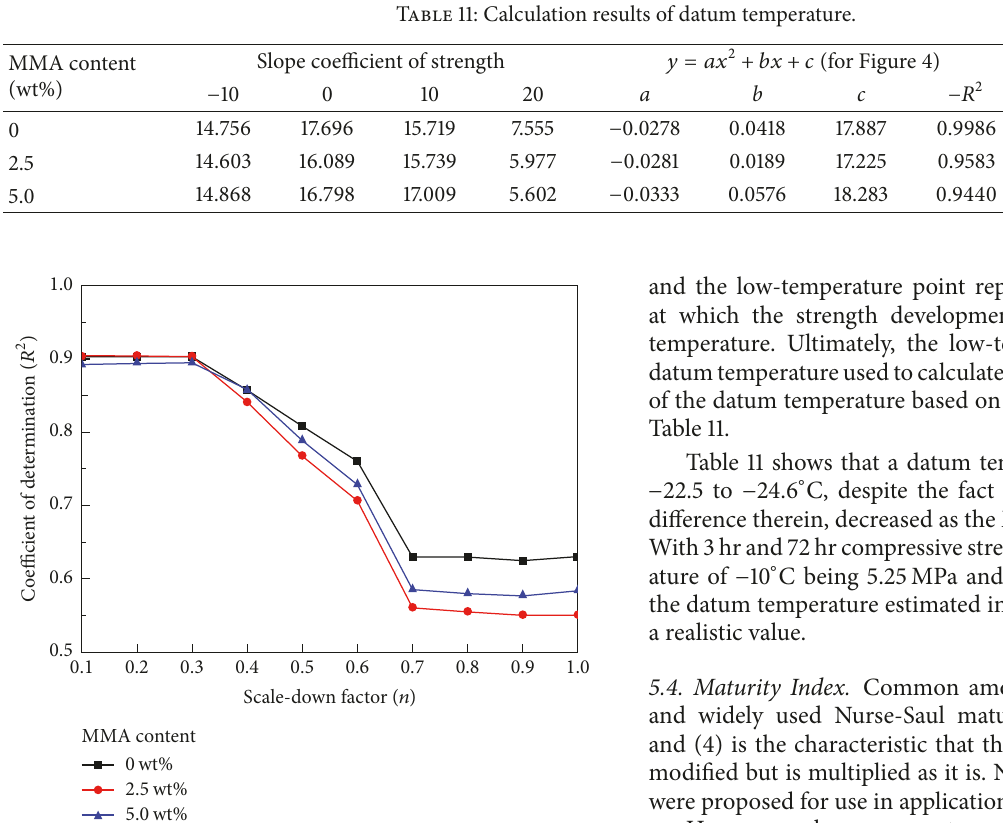
Figure2:Scaled-downfactor( 𝑛 )versuscoefficientofdetermination ( 𝑅 2